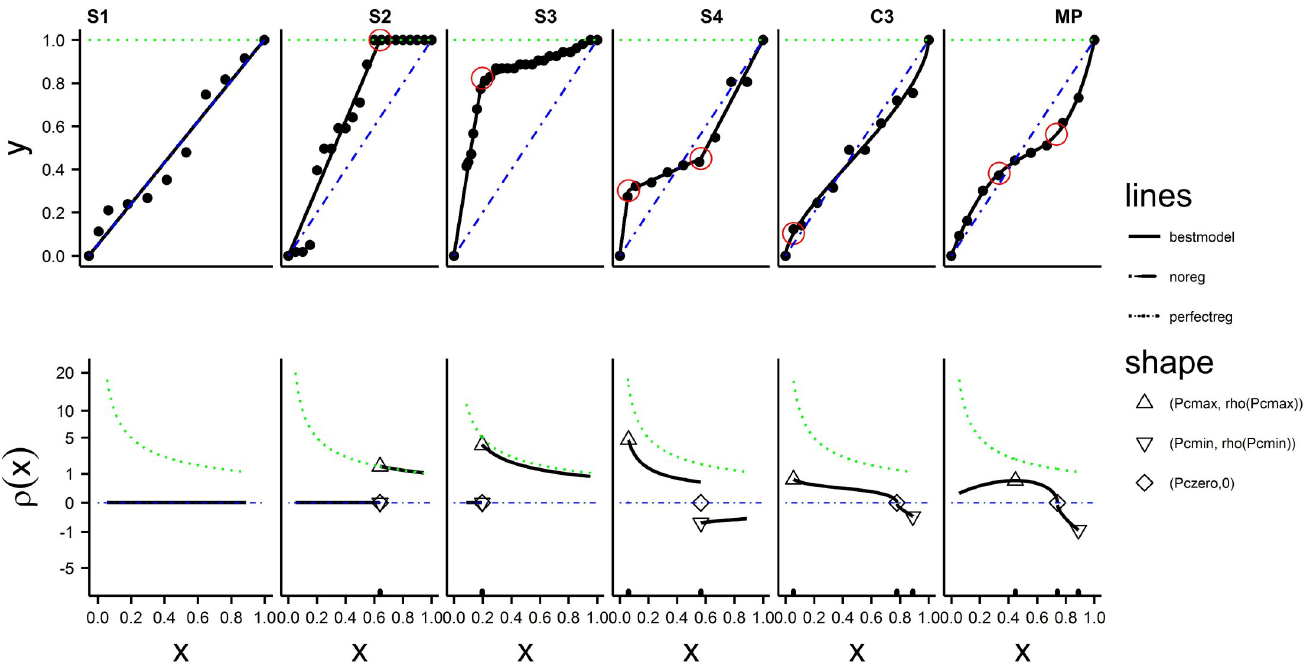
Fig 4. Hypoxia plots (top panels) and matched regulation profiles (bottom panels) for a selected animals with best fitting models S1,S2,S3,S4,C3, and MP. Solid black lines ( ── ) are the predicted lines for y and ρ (x). Observed data points are marked with black dots. The alternating dot-dash blue line (— � — � — � ) is the expected line for a non-regulator for both y and ρ (x). The dotted green line ( ���� ) is the expected line for a perfect regulator for both y and ρ (x). In the hypoxia plot threshold points are marked by a red circle. In the regulation profile points with x values at P c-min , P c-zero and P c-max , are marked with 5 , ^ and Δ , respectively, and their locations on the x-axis are marked with tics just above the axis.